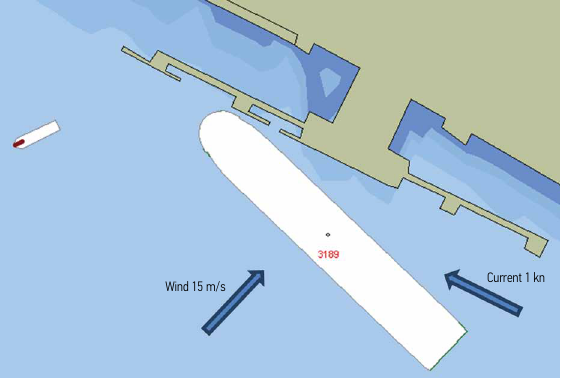
Fig. 7. The force required for tug pulling in the direction perpendicular to the DP of PANAMAX tanker turning Fig. 4. Scheme for ship maneuvering and external forces left (‘–’) and right (‘+’); – the experimental results were (wind and current) obtained using similar ships under the same environmental conditions (wind – 15 m/s, current – 1 kn)